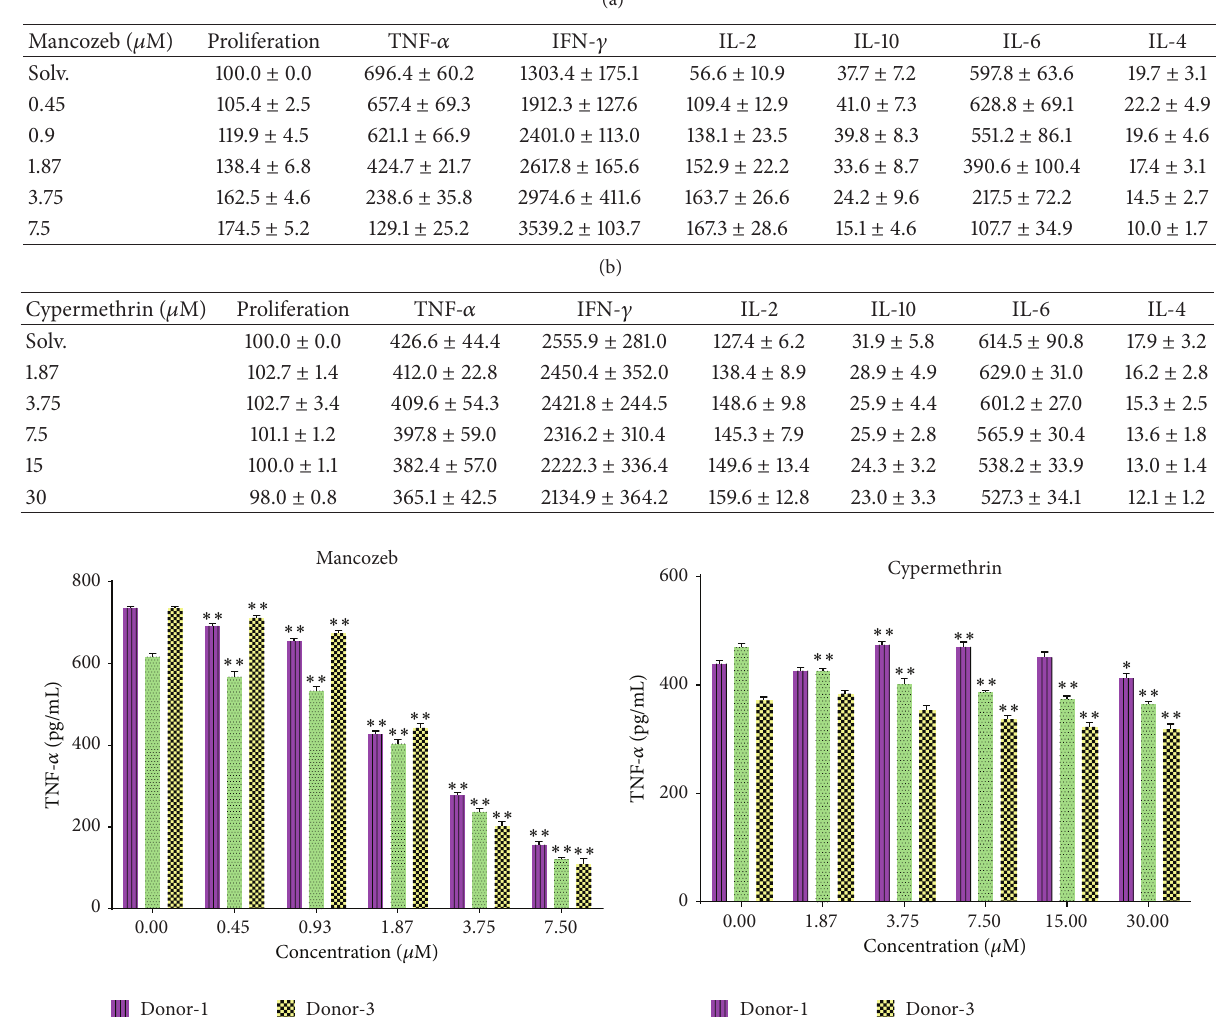
Table 1: Effect on lymphocyte proliferation (%) and T SD from three volunteers (each was conducted in triplicate).